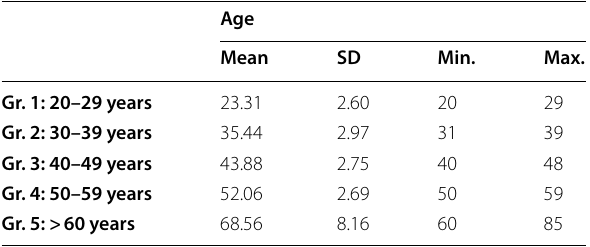
Table 1 Mean (X), standard deviation (S.D), and age range in years of the study groups Age